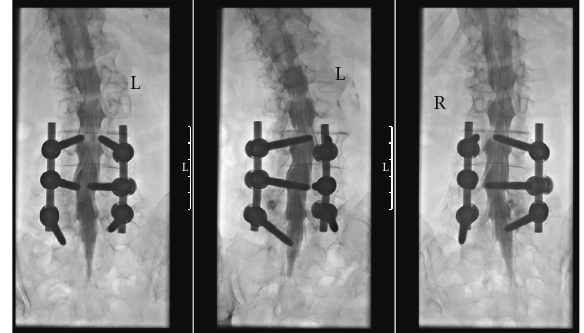
Figure 3: Standard projections in prone position. From left to right: a.p., about 25 ◦ left and right to show the lumbar nerve roots. Taking these images under fluoroscopic control makes sure that even with stabilizing material on three levels the roots are visible from their origin to the foramen.